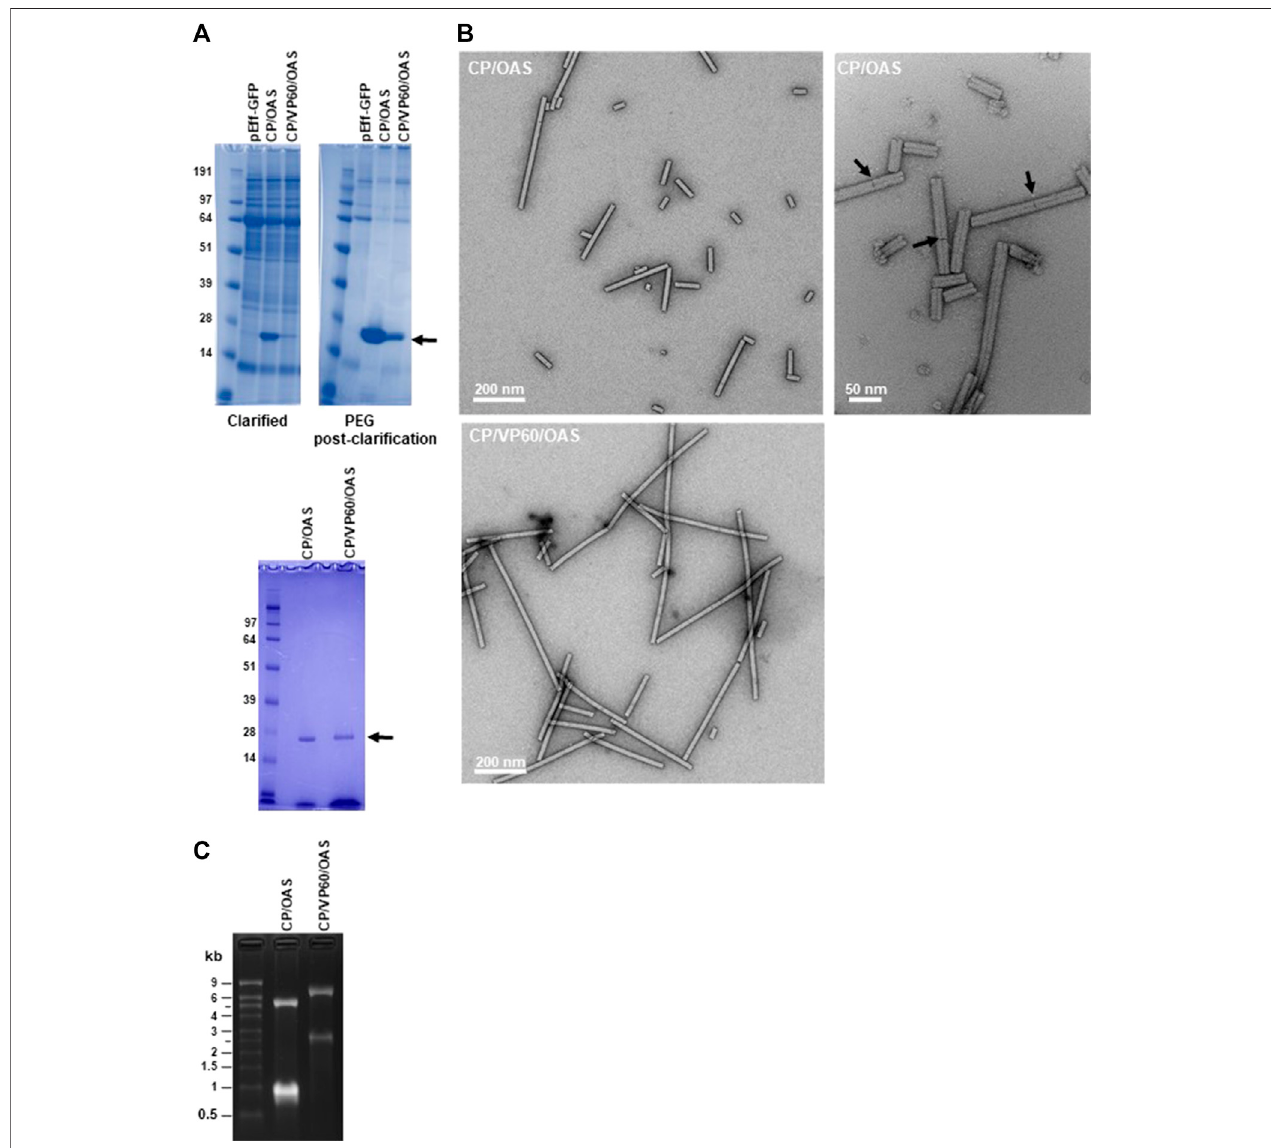
FIGURE 2 | TMV nanorods produced using the pEff vector accumulate in in fi ltrated leaves. (A) Upper panels clari fi ed extract (left) and PEG post-clari fi cation (right) samples of CP/OAS and CP/VP60/OAS separated by NuPAGE-MOPS electrophoresis and stained with Instant Blue protein stain. Lower panel, samples fractionated prior tosucrose-density ultracentrifugation. Protein bands corresponding toTMV CP are indicated byan arrow. Further details can be found in Supplementary Figure S2 . (B) Transmission electron microscopy images of nanorods of CP/OAS upper panels and of CP/VP60/OAS, lower panel. Arrows indicate differential uranyl acetate staining revealing end-to-end nanorod orientation. Scale bar 50, right panel or 200 nm, left panels as shown. (C) Ethidium bromide-stained agarose gel of RNA extracted from CP/OAS and CP/VP60/OAS nanorods. M, RNA size ladder.